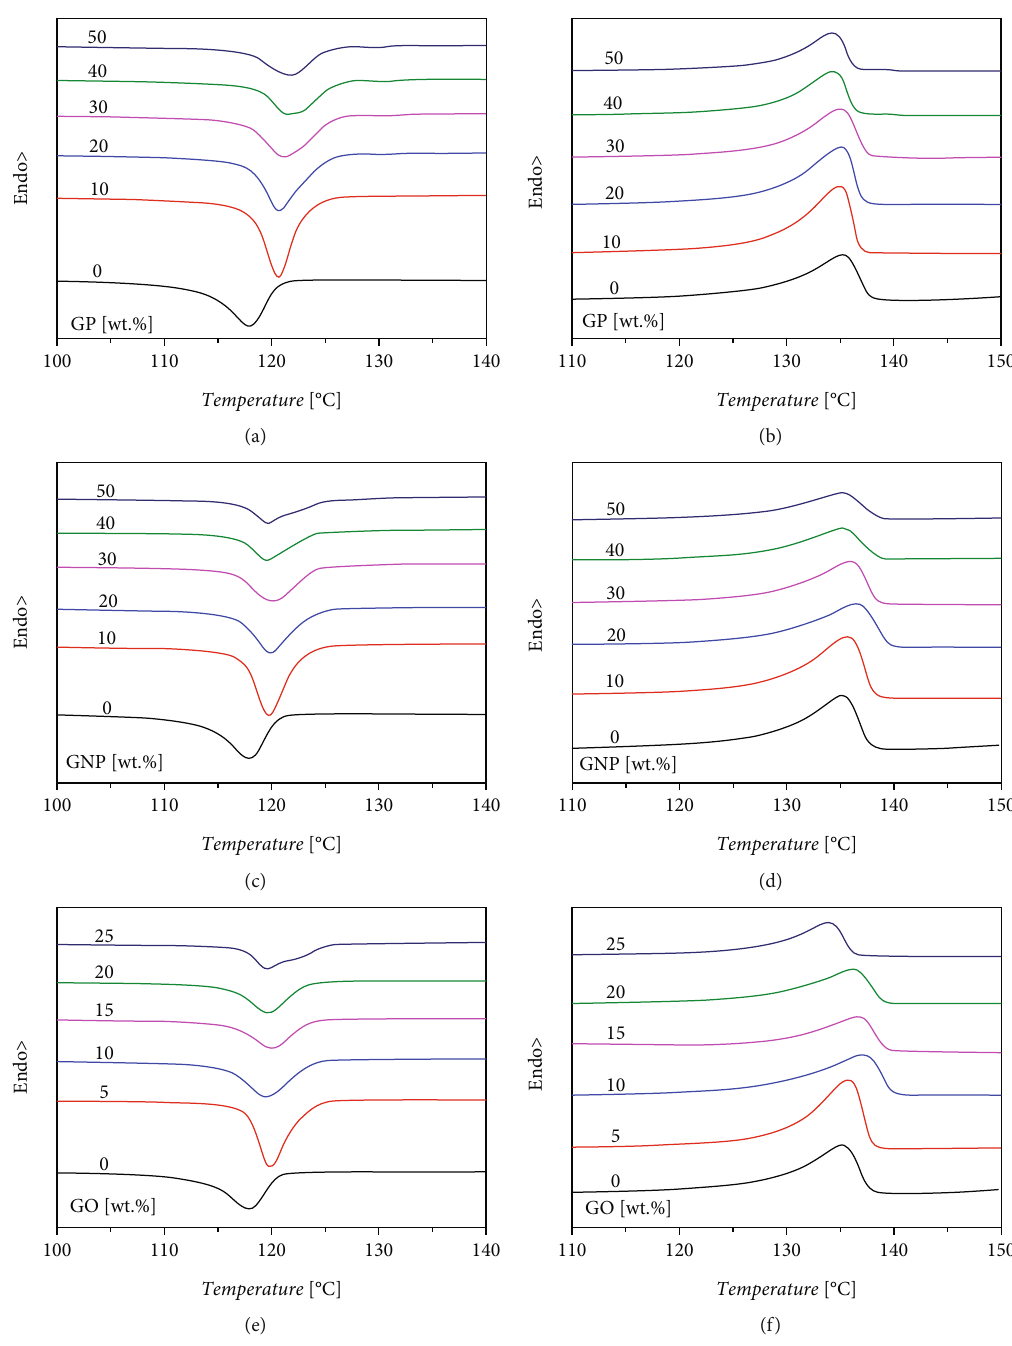
Figure 5: The DSC curves of (a and b) GP/UHMWPE, (c and d) GNP/UHMWPE, and (e and f) GO/UHMWPE